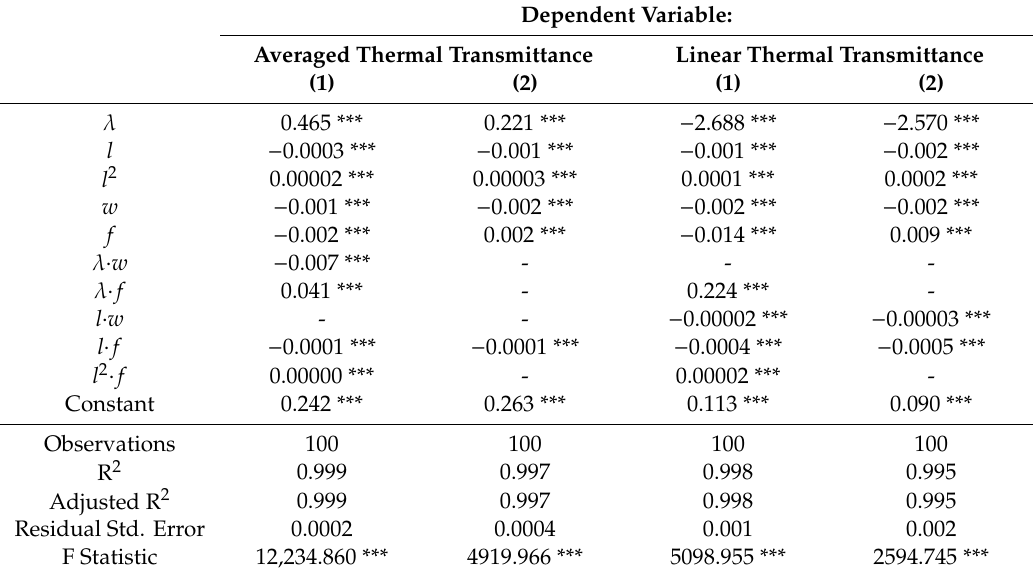
Table 4. Models for the averaged thermal transmittance and linear thermal transmittance: (1)—floor on timber joists, (2)—the self-supporting